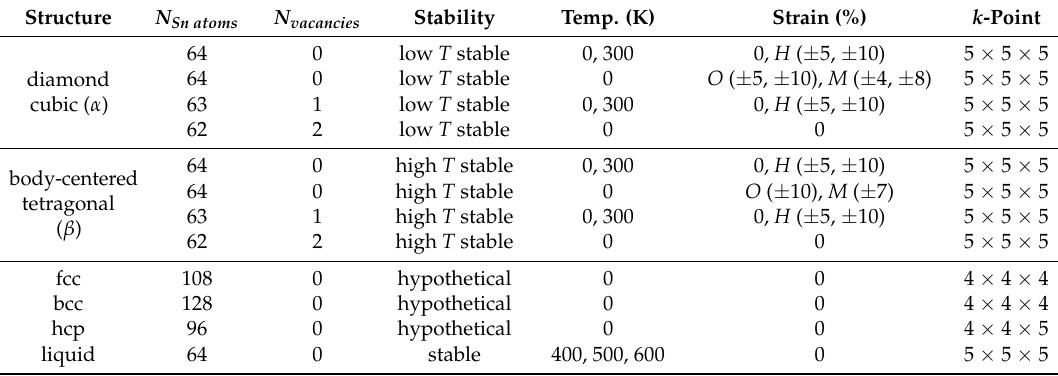
Table 1. Atomic configurations considered in the present density functional theory (DFT) calculations. In the Stability column, “stable” indicates that the structure is reported in an equilibrium phase diagram. Other phases are labeled as “hypothetical”. The Strain column indicates the strain applied to the supercells, where H , O , and M denote hydrostatic, orthorhombic, and monoclinic strains,